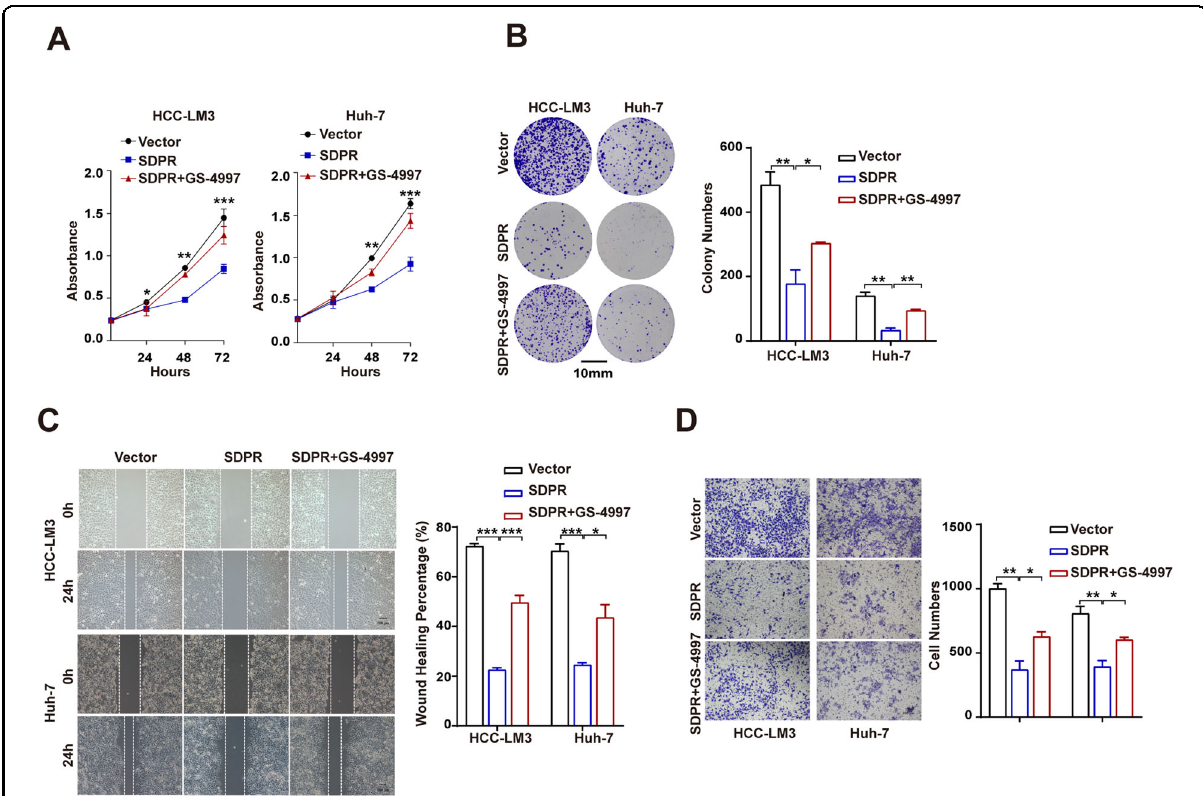
Fig. 7 GS-4997 reversed the anti-tumor effects induced by SDPR overexpression. A , B CCK-8 assays and colony formation assays revealed that GS-4997 rescued HCC cells growth ability in SDPR overexpressing HCCLM3 and Huh-7 cell lines. C , D GS-4997 treatment signi fi cantly restored the effectiveness of SDPR overexpression on cell invasion and cell migration by transwell and wound-healing assays. * p < 0.05; *** p < 0.01; *** p <